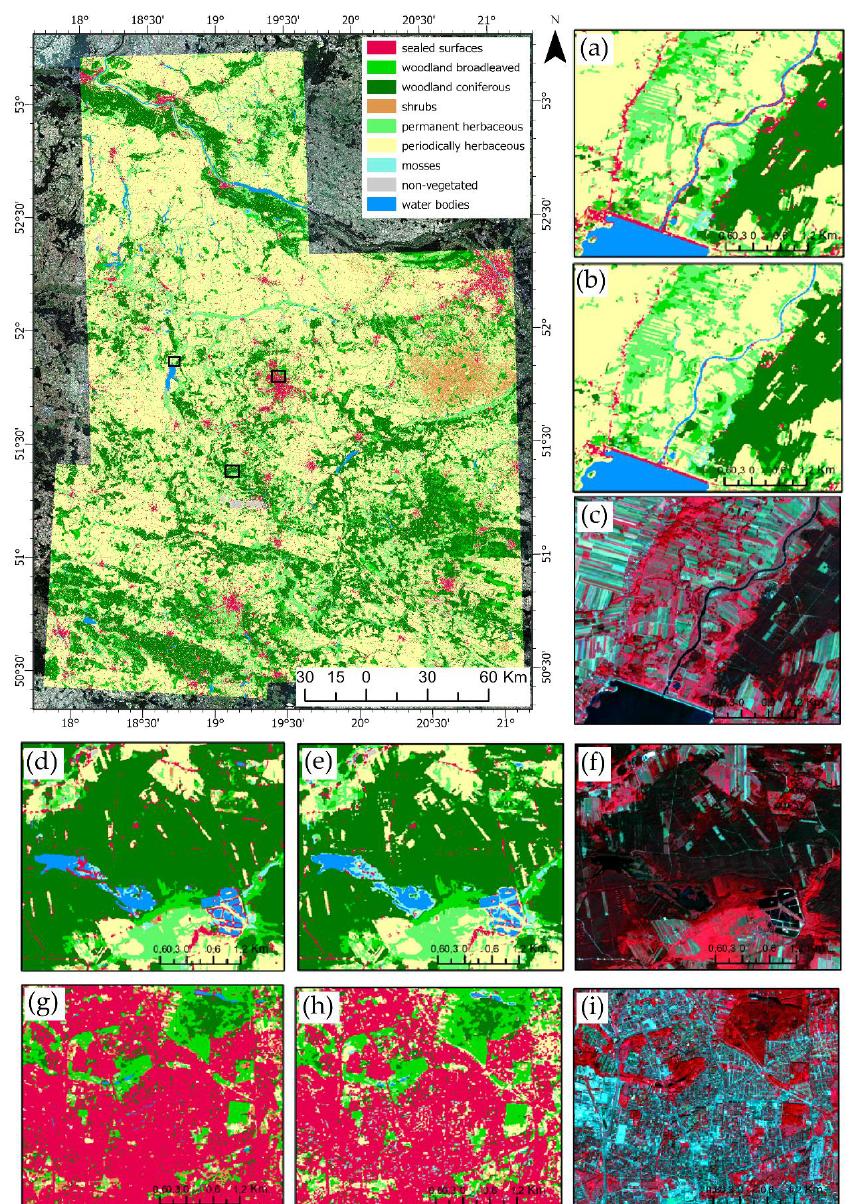
Figure 5. The land cover map of the entire study area derived based on hierarchical classification. Black squares indicate the location of the areas presented on a larger scale as the result of the flat classification ( a , d , g ), hierarchical classification ( b , e , h ) and S-2 colour composite: bands 843 ( c , f , i ).